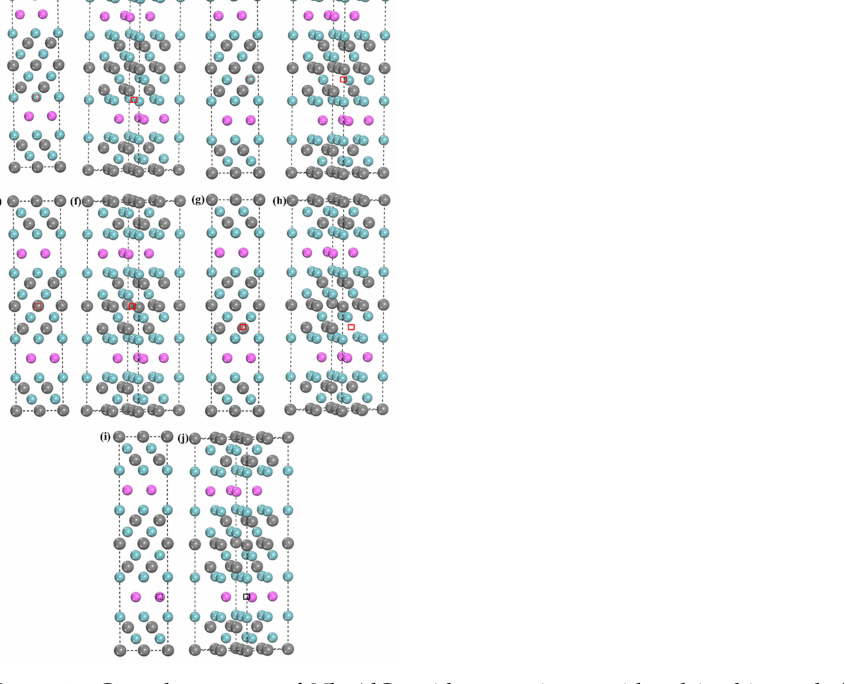
Figure 4. Crystal structure of Nb 4 AlC 3 with vacancies considered in this work ( a , b ) Nb(1)v; ( c , d ) Nb(2)v; ( e , f ) C(1)v; ( g , h ) C(2)v; ( i , j )